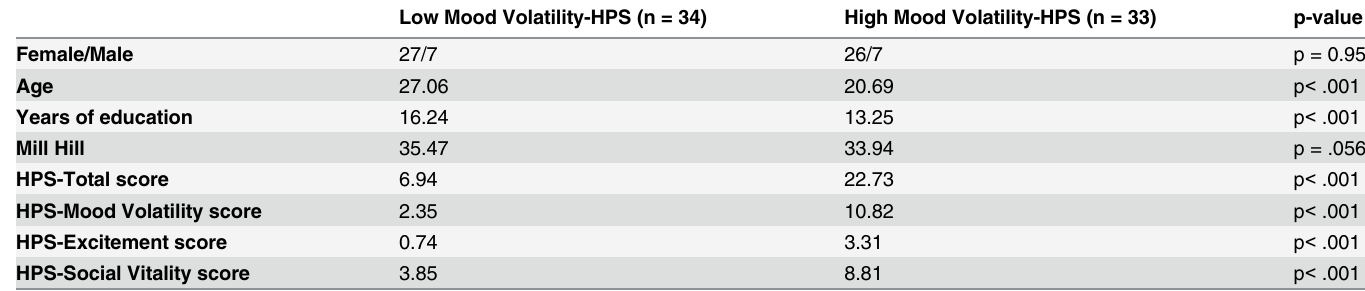
Table 1. Demographics and HPS characteristics for the Low and High Mood Volatility HPS participants included in the ERP